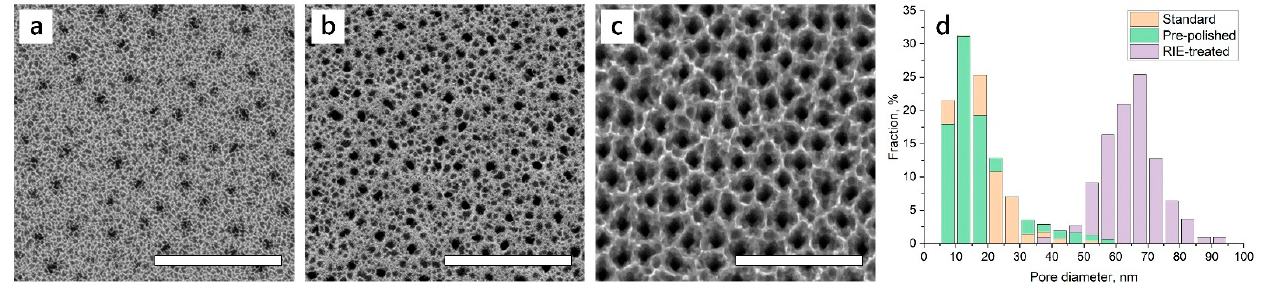
Figure 1. Scanning electron microscopy (SEM) top views of porous silicon (PS) formed in 10 wt.% hydrofluoric acid (HF) solution at 100 mA/cm 2 current density: ( a ) standard, ( b ) pre-polished, and ( c ) standard after reactive ion etching (RIE). The scale bar is 500 nm. ( d ) Pore size (diameter) distribution of the corresponding samples.